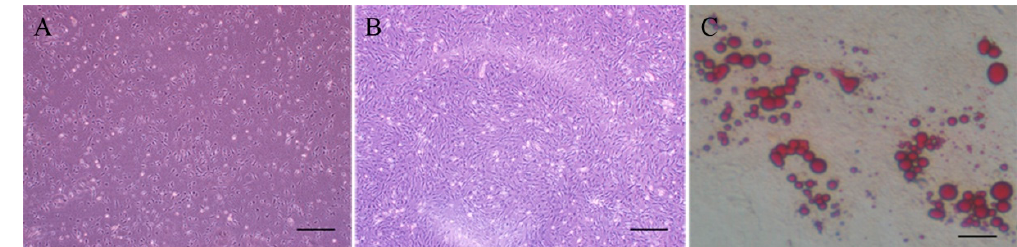
Figure 2. Morphology of the primary cultured cells. ( A ) Morphology of primary cultured pig intramuscular fat cells on the 3rd day (bar = 200 μ m); ( B ) Morphology of primary cultured pig intramuscular fat cells on the 8th day (bar = 200 μ m); and ( C ) Lipid droplets became jacinth colored by oil red O (bar = 200 μ m).